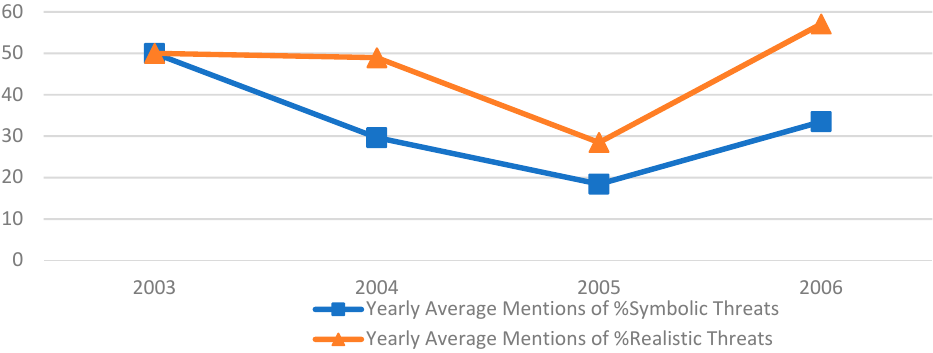
Figure 6. Development of threats in Zarqawi’s statements in yearly average percentage of occurrences.